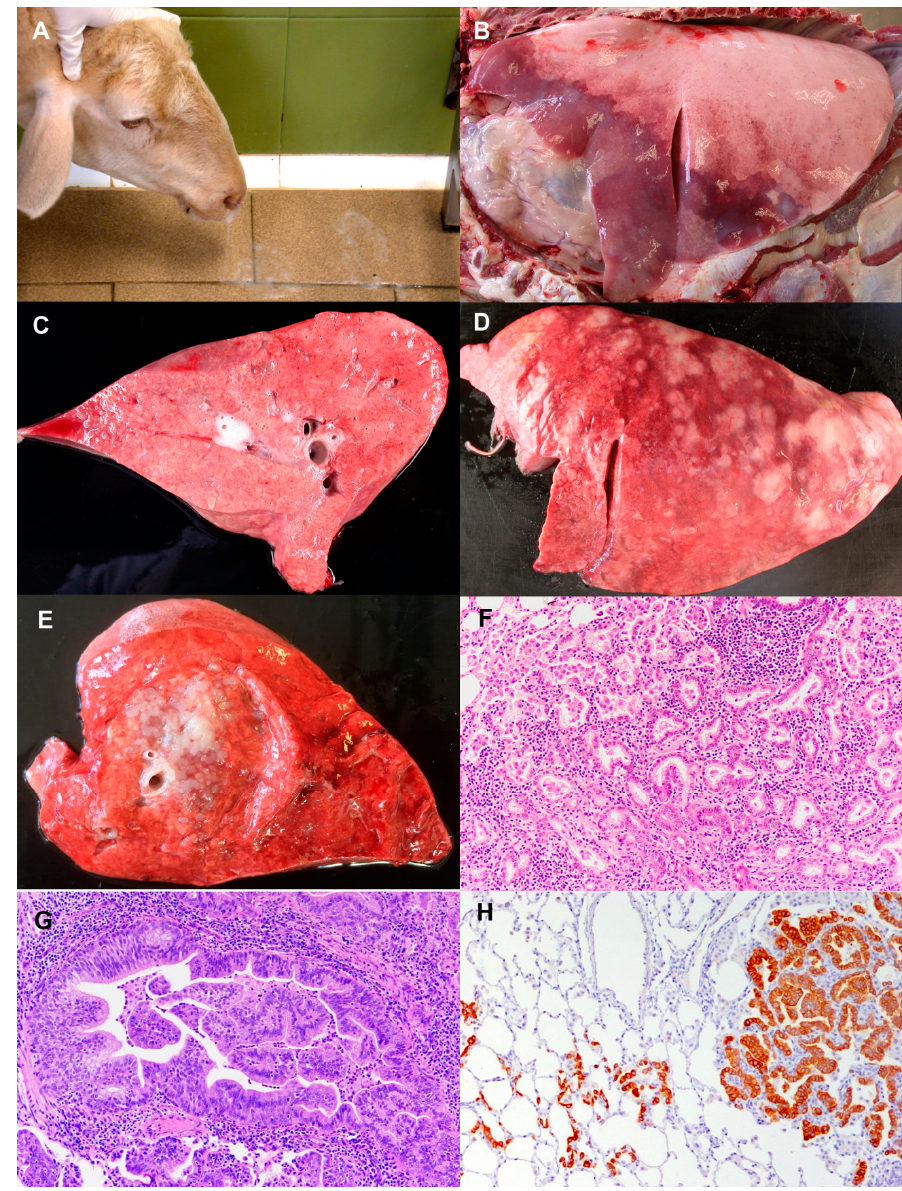
Figure 2. Ovine pulmonary adenocarcinoma (OPA): clinical signs and pathology. ( A ) Four year old sheep showing OPA clinical signs. When head is lowered, frothy sero-mucous fluid comes from the nostrils and pours over the floor. ( B ) Post- mortem examination of thoracic cavity. Classical OPA form. Left lung with cranio-ventral areas purple in colour and consolidated. The rest of the lung shows an increase in volume and is lighter in colour. ( C ) Right caudal lung section. Classical OPA. Lung section showing granular appearance foci and foamy fluid pouring from main airways. ( D ) Left lung from a sheep showing atypical OPA form. Multiple white nodules of various sizes distributed throughout the lung surface. ( E ) Section of lung from right caudal lobe. Atypical OPA. Multiple white nodules with various sizes: bigger ones coalescing close to a central main bronchus and others expanding to close lung areas. ( F ) Histopathology of OPA lesion. Alveolar epithelial cells proliferate following a lepidic pattern. Alveolar wall is replaced by cuboidal cells into a tubular or papiliform pattern. Tumour stroma is infiltrated mainly by lymphocytes. Numerous macrophages are filling alveolar lumens in the tumours and in the close areas. Hematoxylin-eosin. 100 × . ( G ) Histopathology of OPA lesion. Bronchiole with epithelium transformed into papiliform growth almost completely filling the lumen. Hematoxylin-Eosin. 100 × . ( H ) Immunohistochemistry using a mouse monoclonal antijaagsiekte sheep retrovirus envelope (JSRV Env) protein. Cellular membranes and cytoplasms of neoplastic cells of a tumour nodule are labelled. In the adjacent alveoli, positive cells are observed either isolated or in small groups. 100 ×